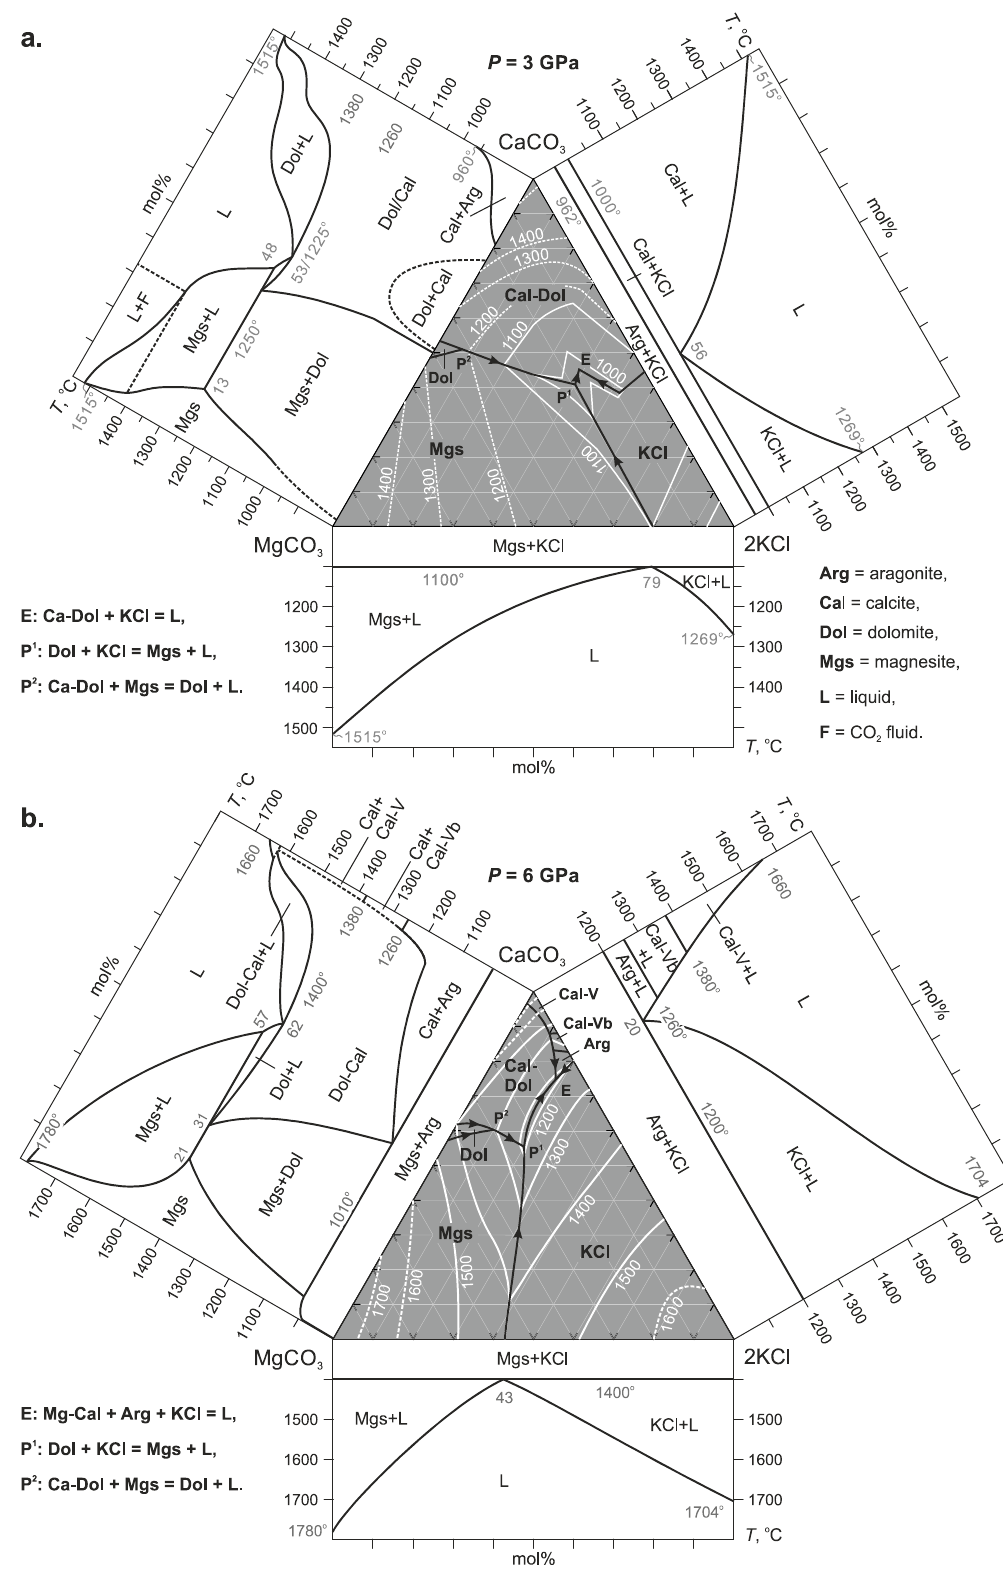
Figure 8. Isobaric equilibrium diagrams for the system KCl–MgCO 3 –CaCO 3 at 3 GPa (this study) ( a ) and at 6 GPa [32,37] ( b ) Black lines are boundary lines and white lines (dashed where inferred) are liquidus isotherms with temperatures in degrees Celsius. The phase relations in the MgCO 3 –CaCO 3 binary are from [37].